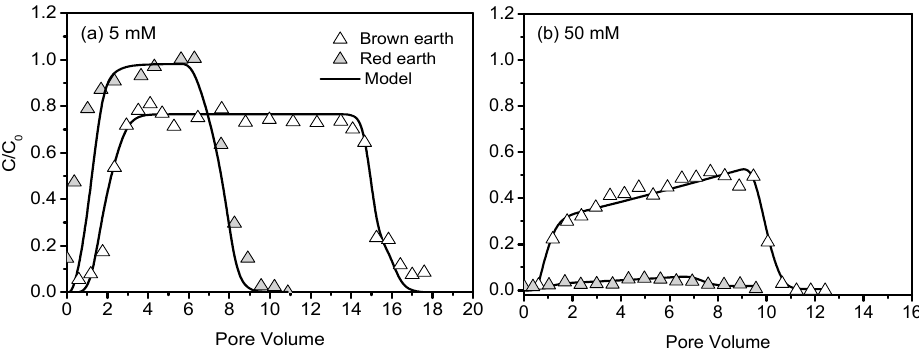
Figure 5. Breakthrough curves of CNCs from natural loamy soils at 5 mM ( a ) and 50 mM ( b